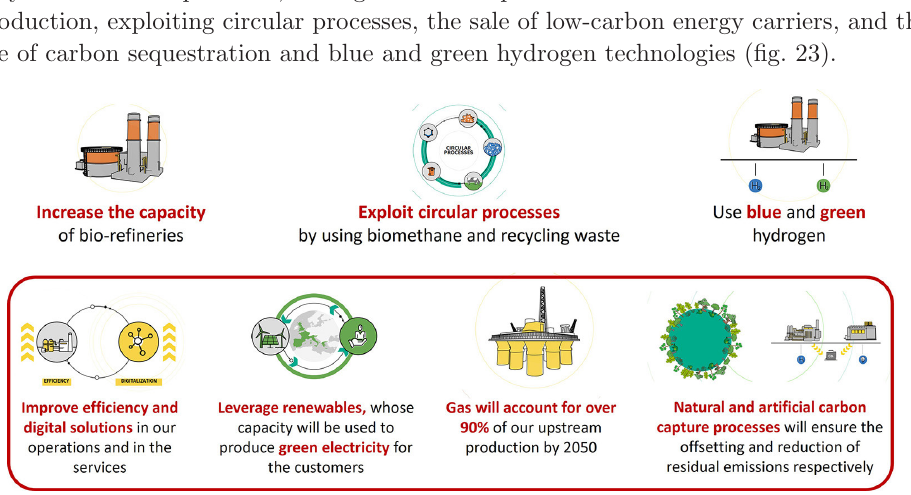
Fig. 23. – Eni’s strategy for decarbonisation (Source: Eni,